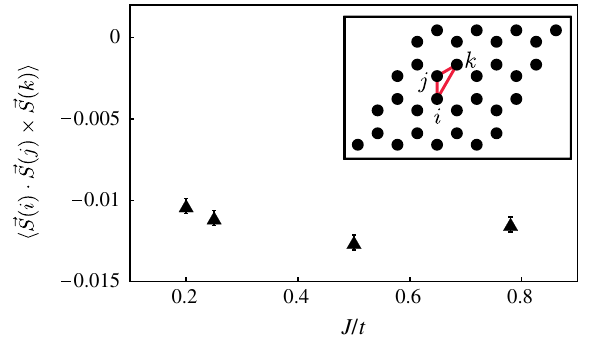
FIG. 14. Spin chirality of a characteristic triangle (inset) in 32- site sample, from t - J model DMRG ground state projected into sector having center-of-mass momentum Γ , and C 6 eigenvalue exp ð − i π = 3 Þ . The chirality is averaged over all translations and rotations of the triangle to reduce statistical